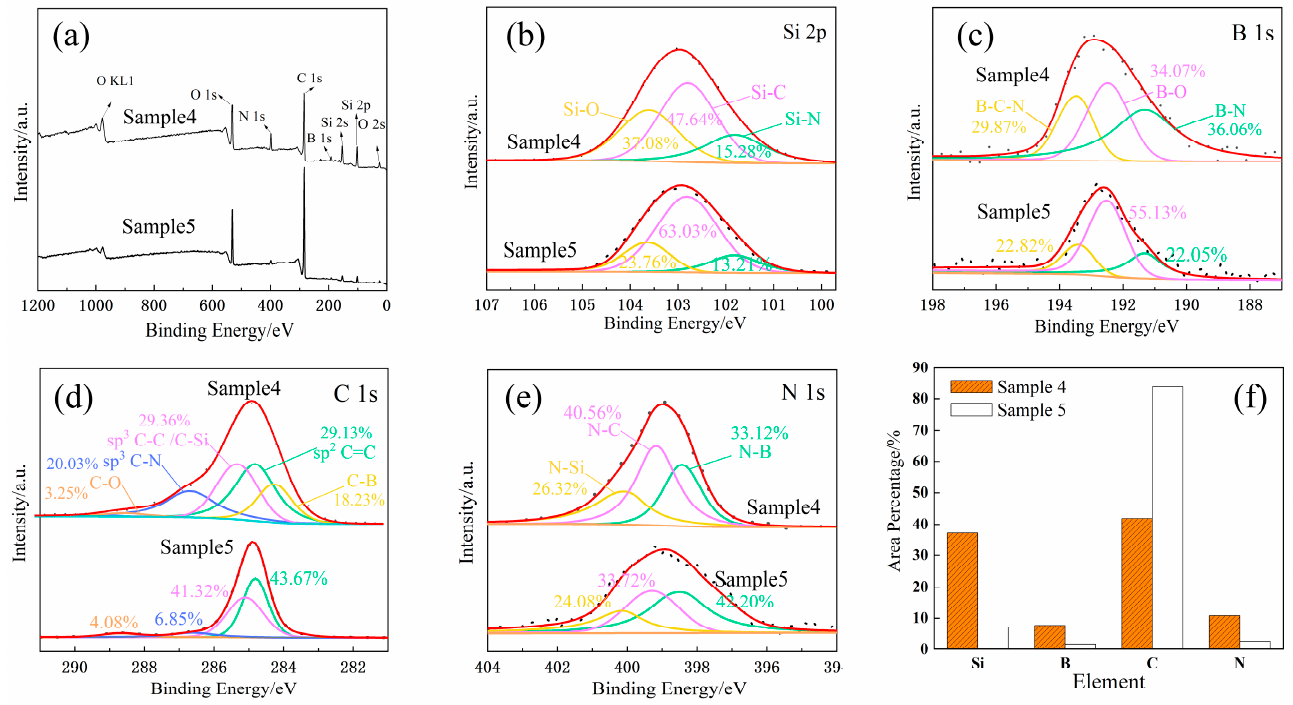
Figure 2. XPS spectra of Samples 4 and 5 and the content of each element. ( a ) Full Spectrum, ( b ) Si 2p narrow sweep, ( c ) B 1s narrow sweep, ( d ) C 1s narrow sweep, ( e ) N 1s narrow sweep, ( f ) Elemental content change.